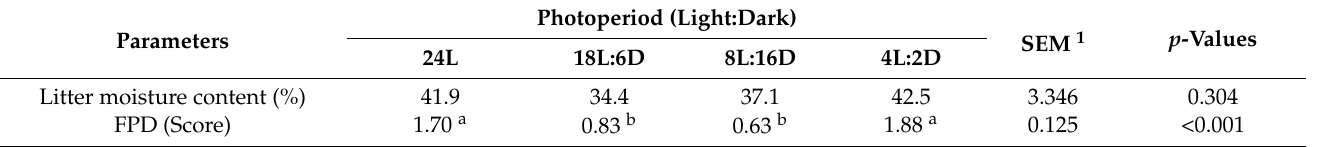
Table 6. Effect of photoperiod on litter moisture content and occurrence of footpad dermatitis (FPD) of